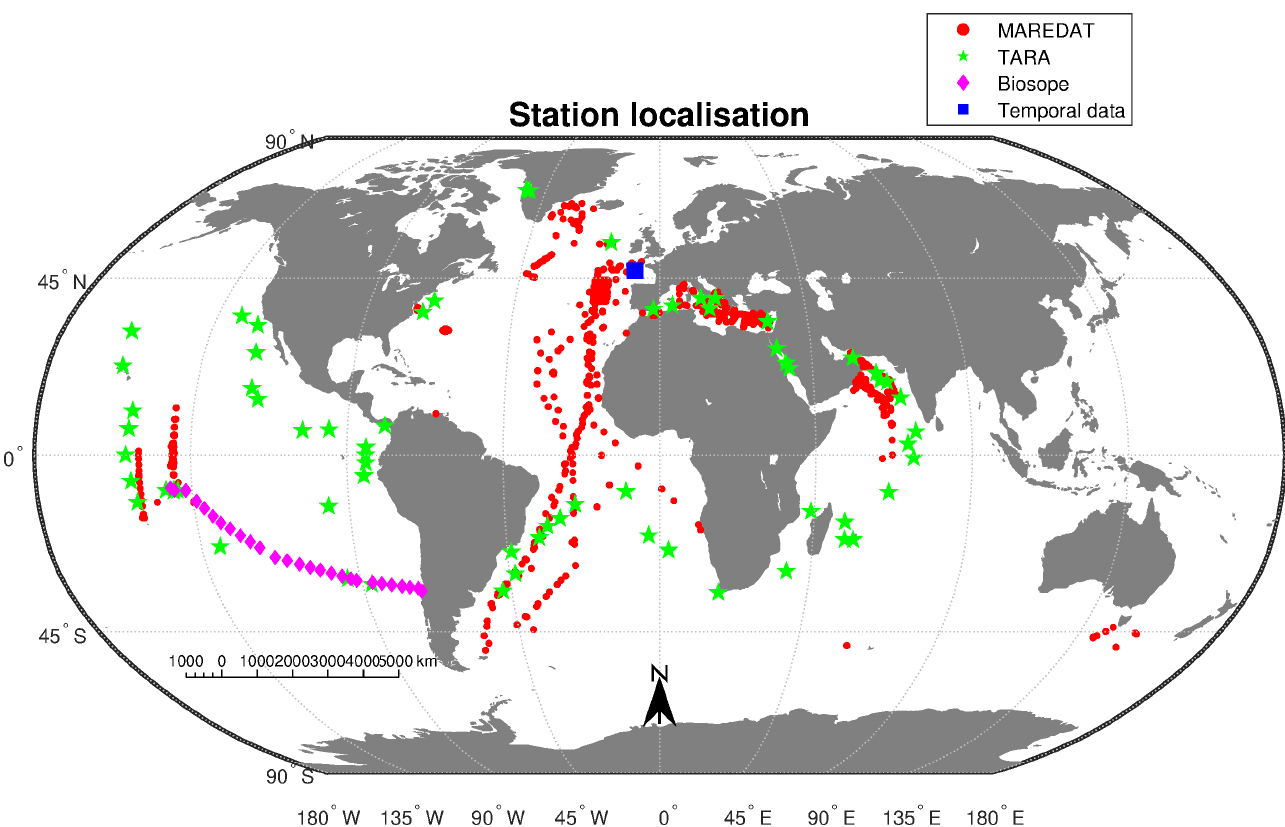
Figure 1. Geographical repartition of the stations. Red dots represent the repartition of the 1614 stations from MAREDAT constituting the training set, green stars represent the repartition of the 66 stations from Tara constituting the test set. The magenta diamonds represent the Biosope trajectory, a subset of the MAREDAT dataset, and the blue square indicates the location where satellite data were obtained in order to test the developed